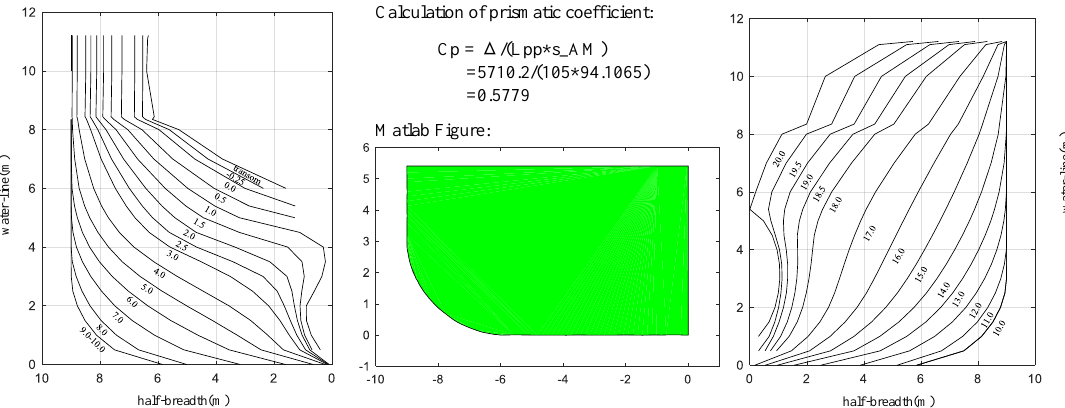
Figure A1. Molded lines of amidships area [29,30] (the figure permission has been achieved from Dalian Maritime University).